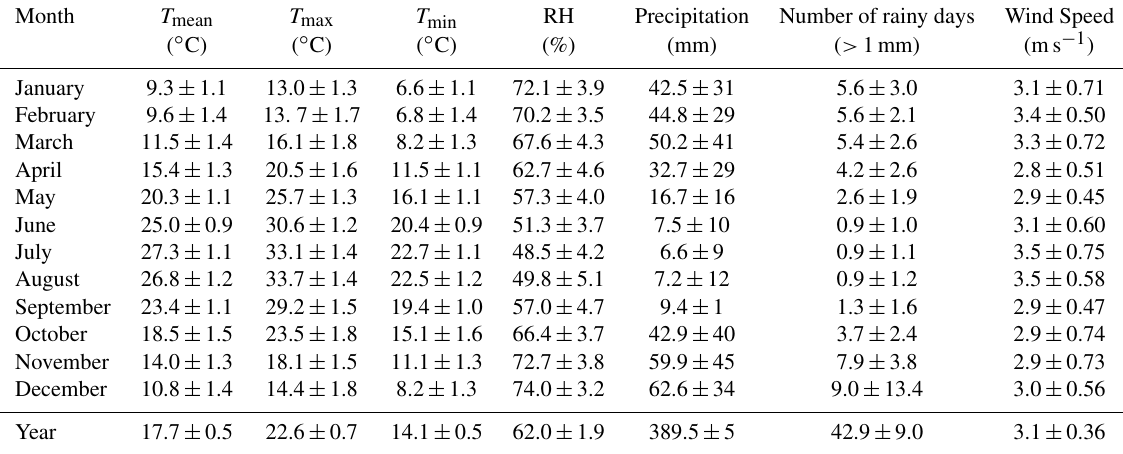
Table 1. Mean monthly and yearly values with standard deviations of basic climatic elements in Athens (NOA), calculated from the WMO climatic period (1971–2000)*.